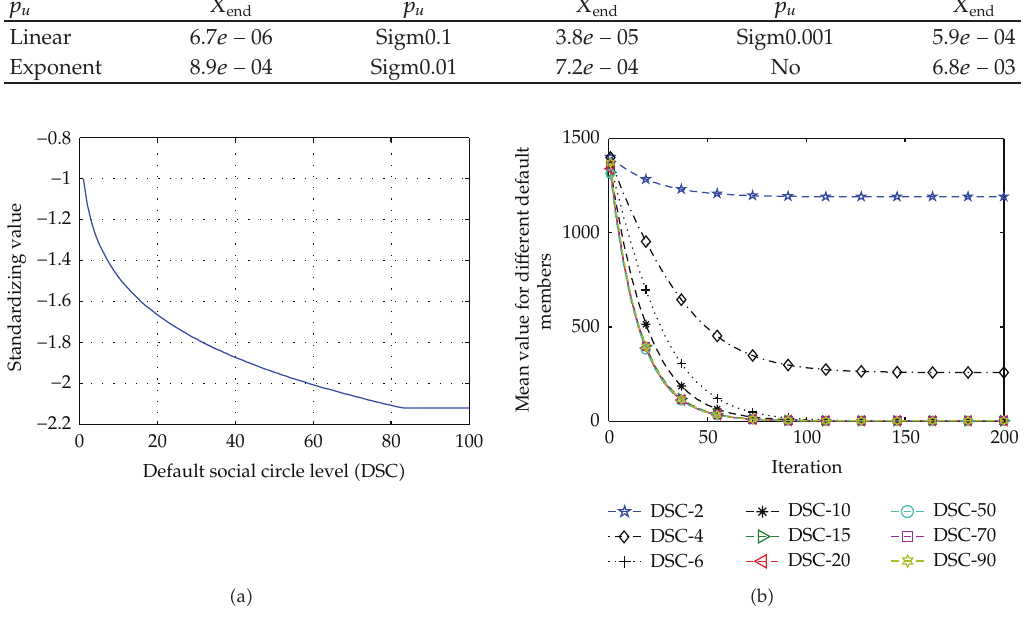
Figure 5: E ff ect of the default social circles on the